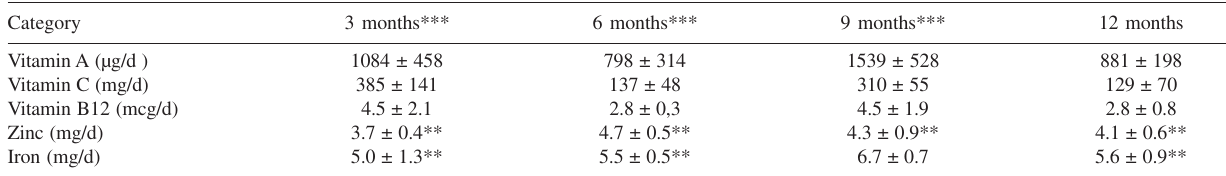
Table 2 - Vitamin and mineral content of the diet (mean ± SEM)* Category